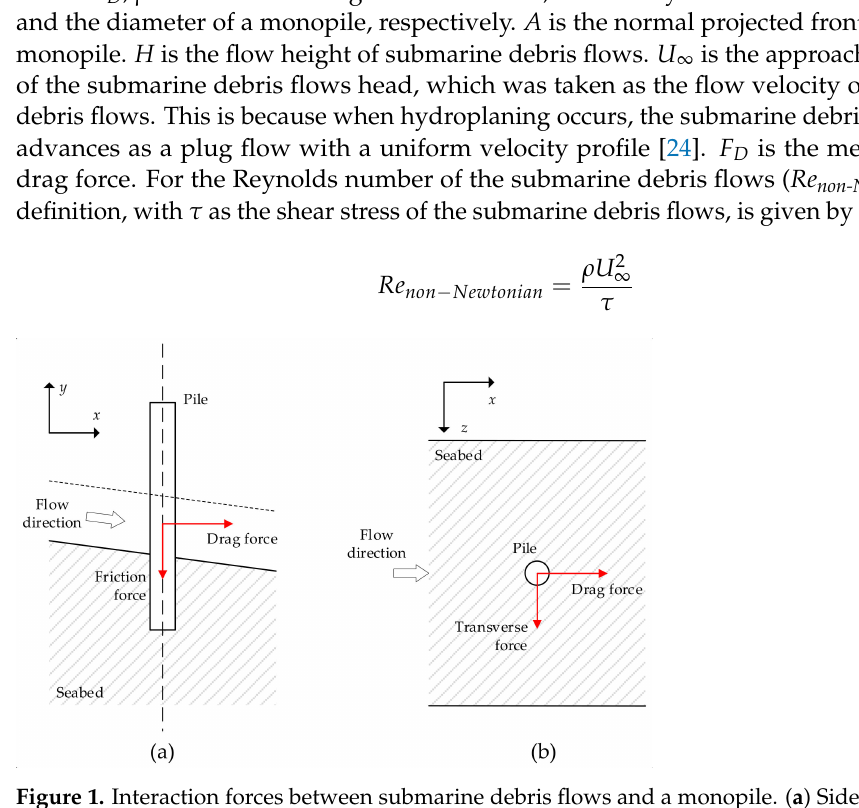
Figure 1. Interaction forces between submarine debris flows and a monopile. ( a ) Side view; ( b ) Top